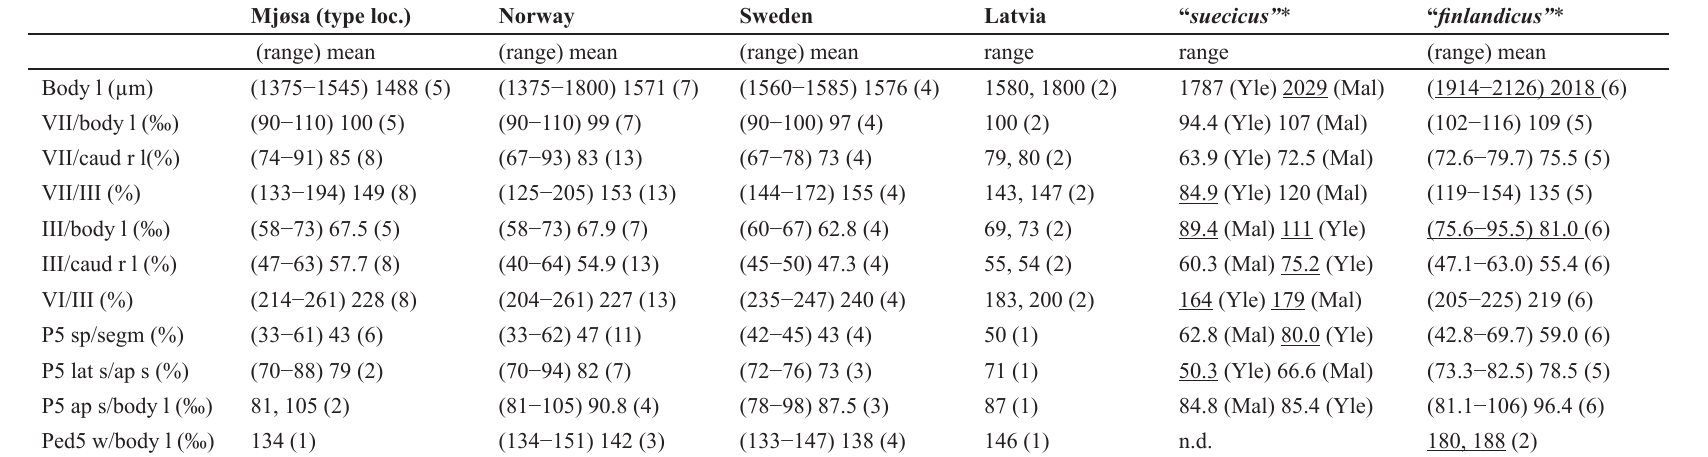
Body l = body length; VII/body l = length of dorsal caudal seta / body length; VII/caud r l = length of dorsal caudal seta / length of caudal ramus; VII/III = length of dorsal caudal seta / length of posterolateral caudal seta; III/body l = length of posterolateral caudal seta / body length; III/caud r l = length of posterolateral caudal seta / length of caudal ramus; VI/III = length of terminal accessory caudal seta / length of posterolateral caudal seta; P5 sp/segm = length of medial spine on the distal segment of leg 5/ length of the distal segment of leg 5; P5 lat s/ap s = length of lateral seta on the proximal segment of leg 5 / length of apical seta on the distal segment of P5; P5 ap s/body l = length of apical seta on the distal segment of P5/ body length; Ped5 w/body l = max. width of pediger 5 / body length.